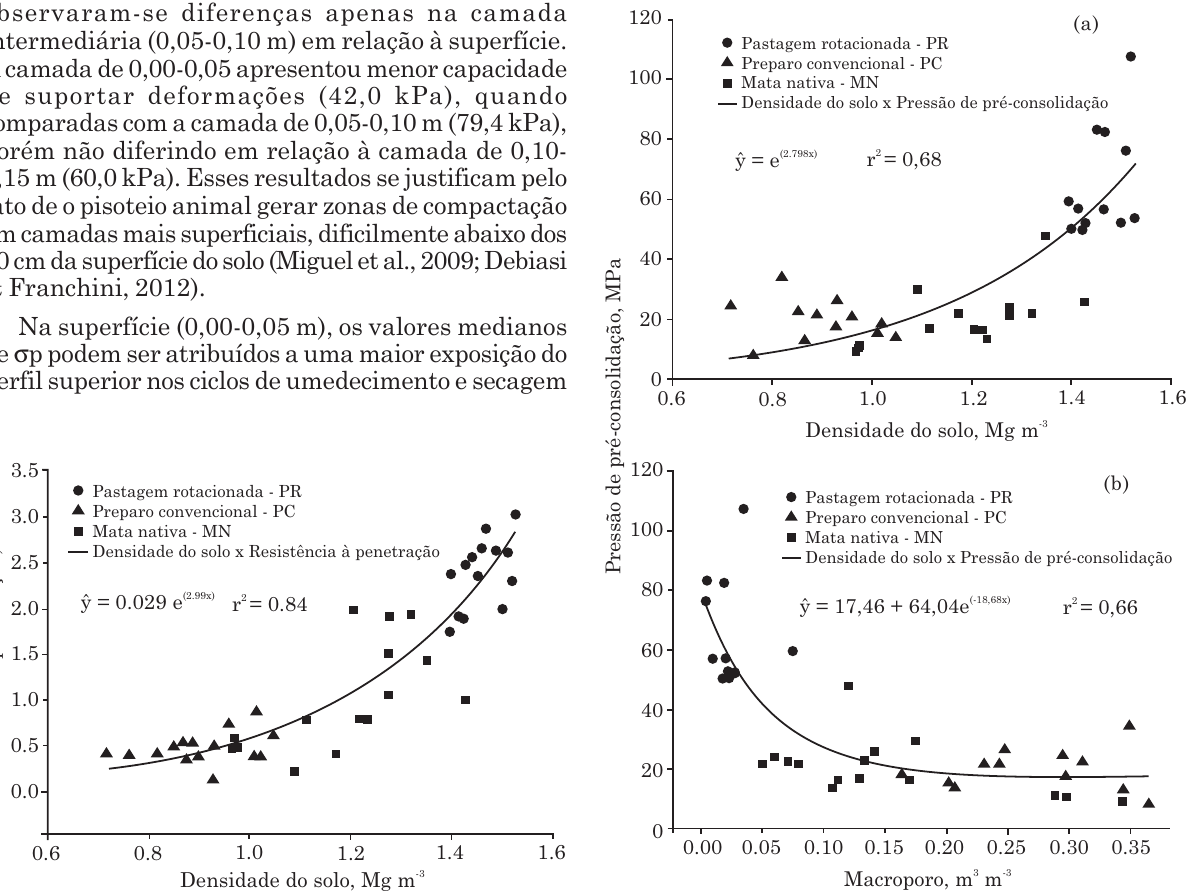
Figura 1. Valores de resistência à penetração, nos três sistemas de uso do solo, em função do estado de compactação do solo.